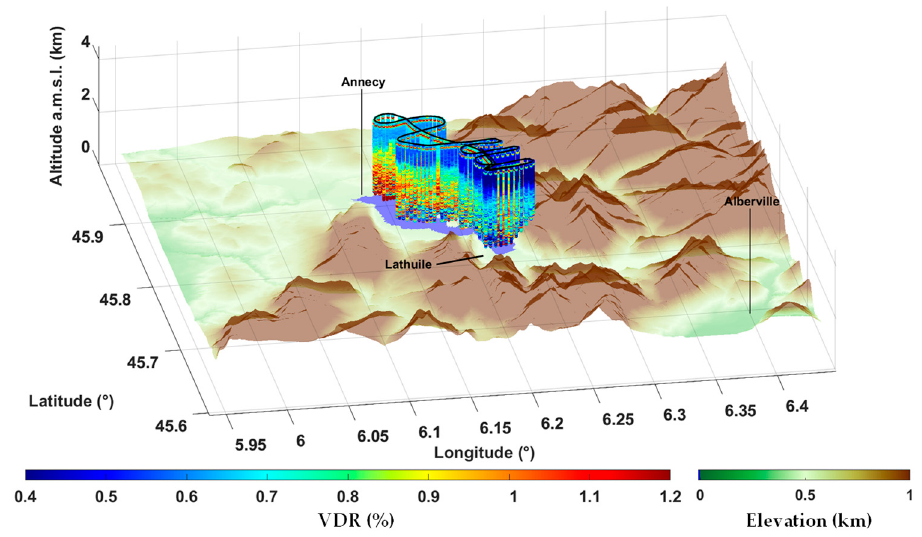
Figure 3. Linear volume depolarization ratio (VDR) derived from the airborne lidar over Lake Annecy on 18 June 2019, 11:00–12:30 LT.